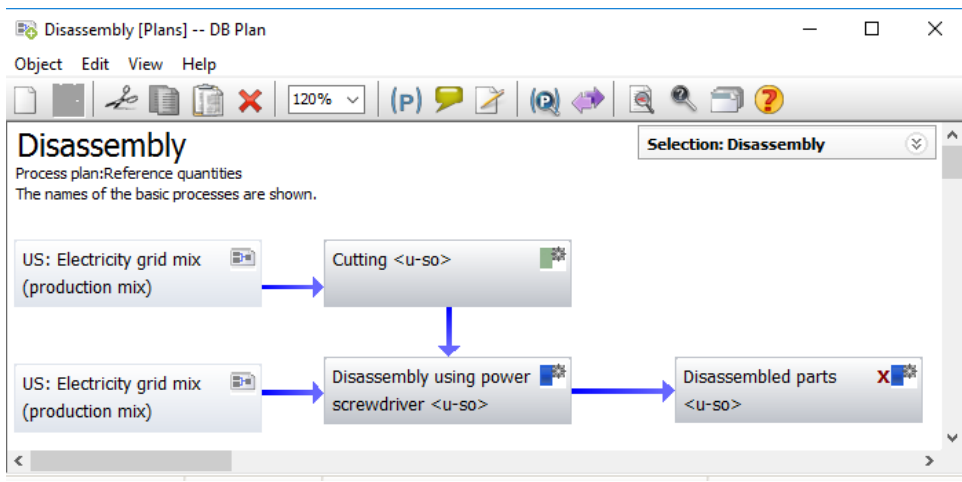
Figure 3. The disassembly phase modeling using GaBi software.